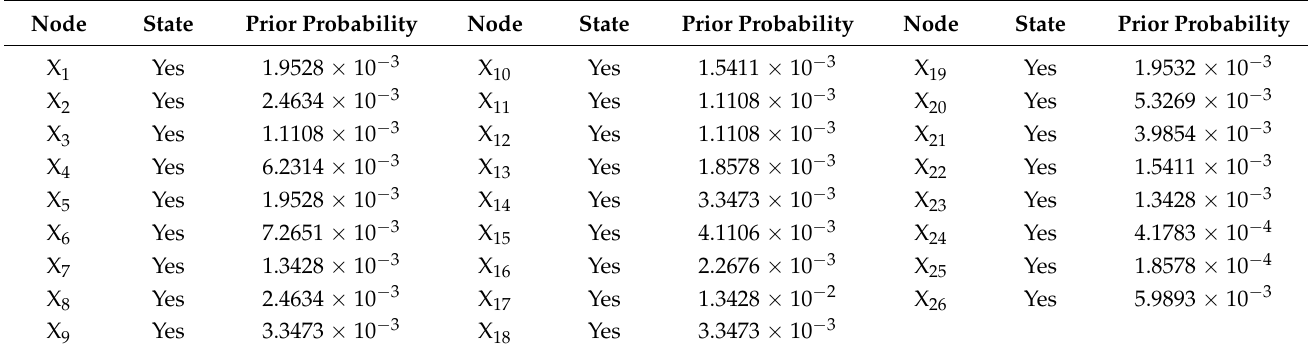
Table 4. The prior probabilities of the root nodes.